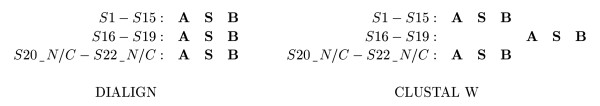
Alignments for '. The DIALIGN alignment (left) was found to be stable. The other alignment is only one example of a variety of different alignments obtained for this sequence set and its subsets.